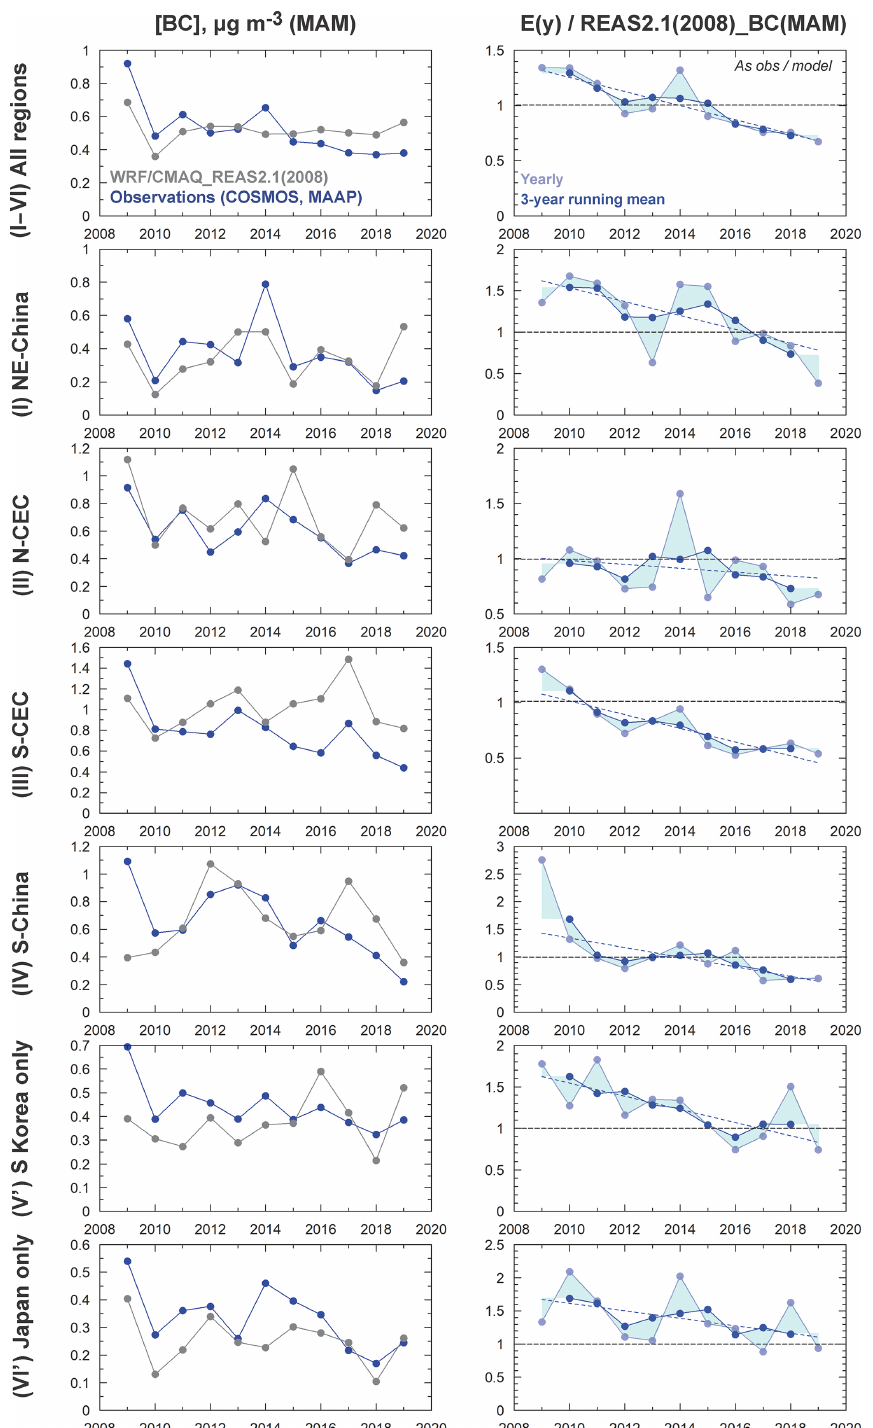
Figure 6. Same as Fig. 5 but for spring (MAM), which is shown without footprint representation. Emissions correction factor – E( y )/REAS2.1(2008); NE China – northeastern China; N-CEC – north-central East China; S-CEC – south-central East China; and S China – southern